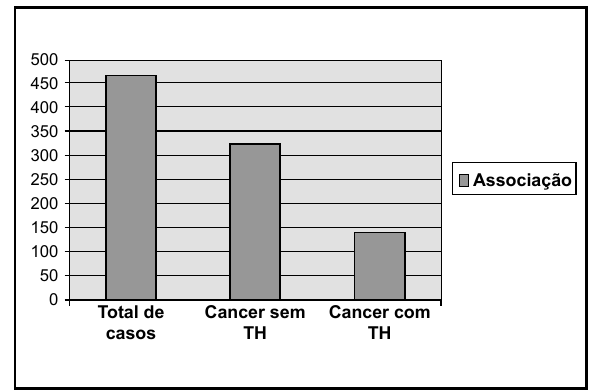
Figura – Frequência de TH no carcinoma papilífero TH: tireoidite de